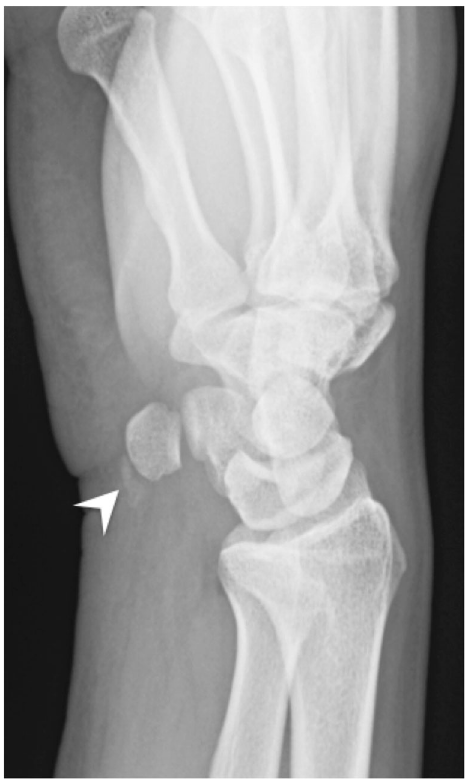
Fig. 7 Calcifying tendinopathy of flexor carpi ulnaris. Oblique radiograph of the wrist shows HADD in the flexor carpi ulnaris with amorphous cloudlike calcifications